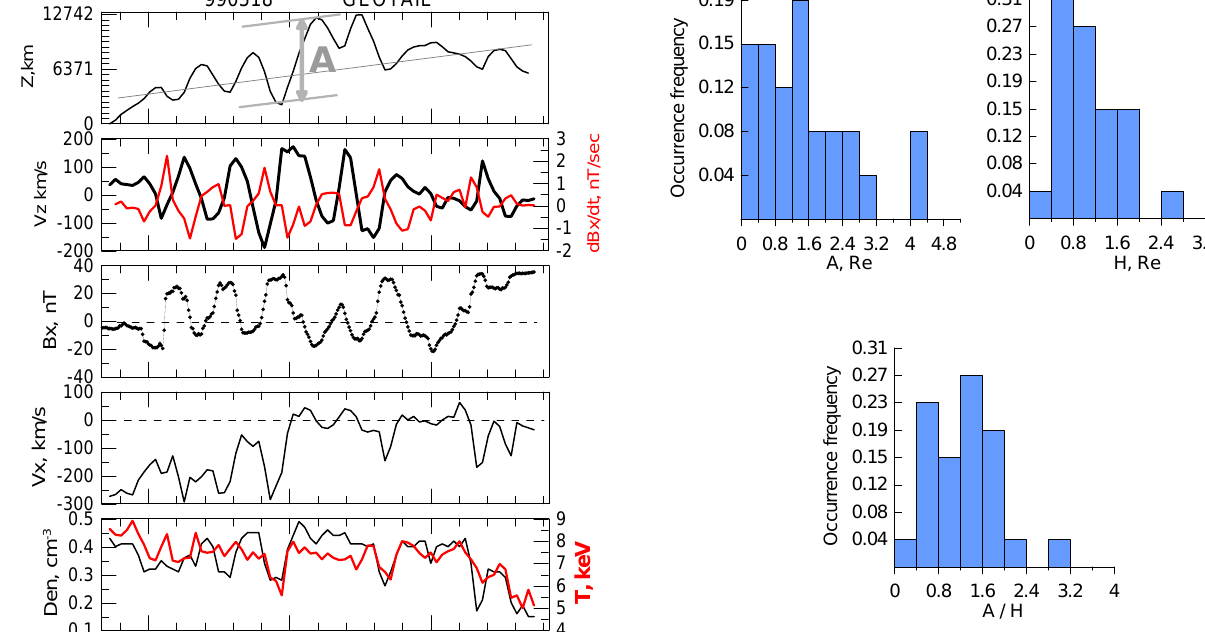
Fig. 8. Example of a sequence of fast current sheet crossings (flap- ping wave) observed by Geotail on 18 May 1999 at [–16.3; 9.0; 4.5]Re GSM.